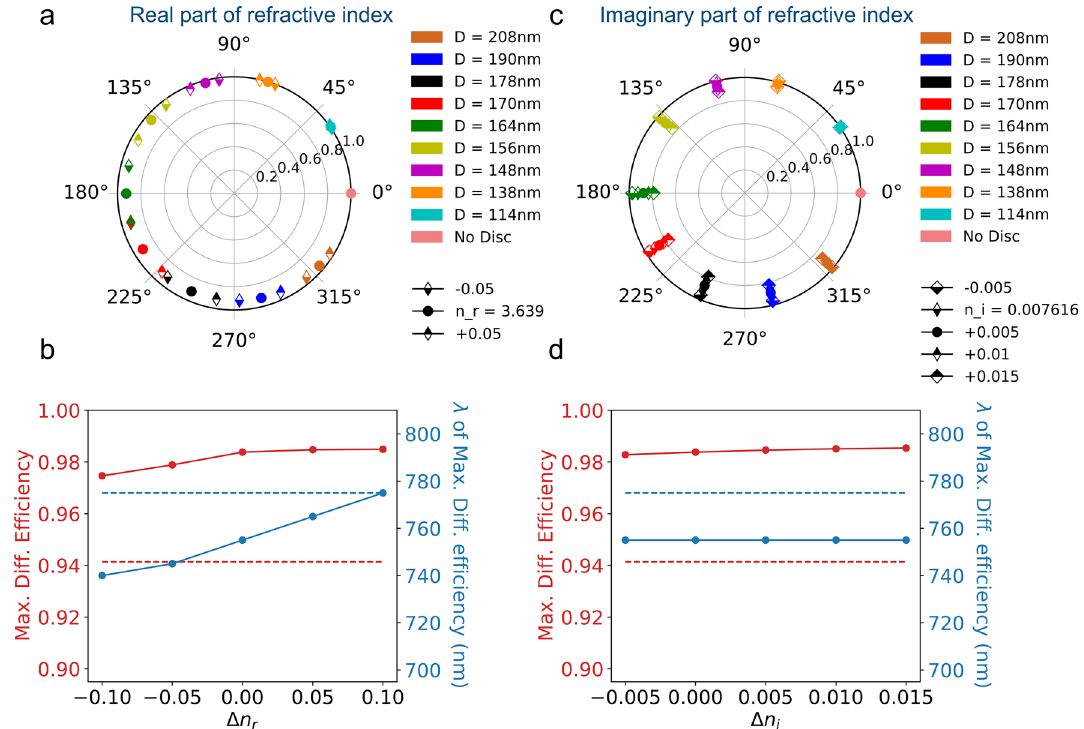
Figure 6. ( a ) Transmission and dephasing induced by an array of silicon nanocylinders on a normally incident (cid:31) = 750 nm plane wave as a function of the real part of the refractive index for the ten selected geometries. ( b ) Diffraction efficiency and wavelength of max. diffraction efficiency as a function of the real part of the refractive index. ( c ) Transmission and dephasing induced by an array of silicon nanocylinders on a normally incident (cid:31) = 750 nm plane wave as a function of the imaginary part of the refractive index for the ten selected geometries. ( d ) Diffraction efficiency and wavelength of max. diffraction efficiency as a function of the imaginary part of the refractive index. The red (resp. blue) dotted lines show the measured values of maximum diffraction efficiency and corresponding